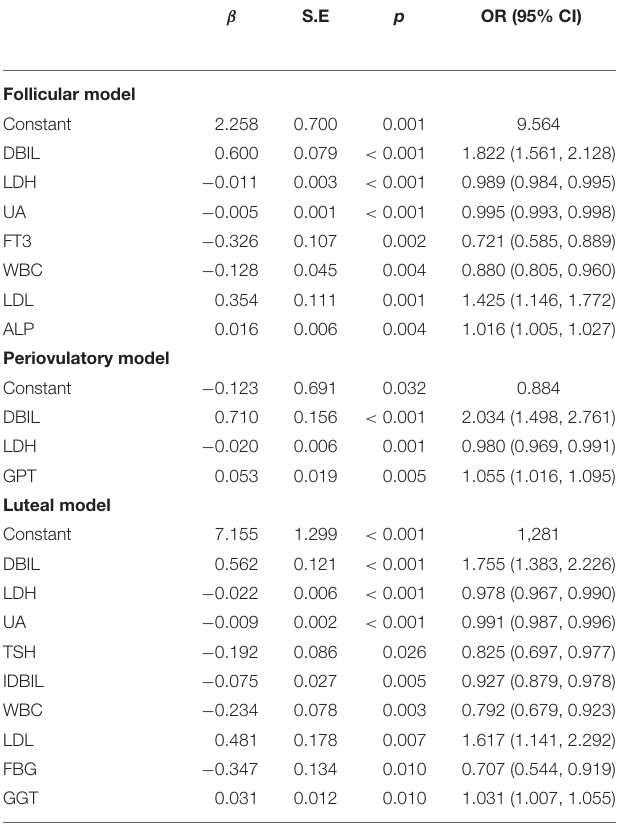
TABLE 4 | Regression analysis for female diagnostic predictors to BD vs.